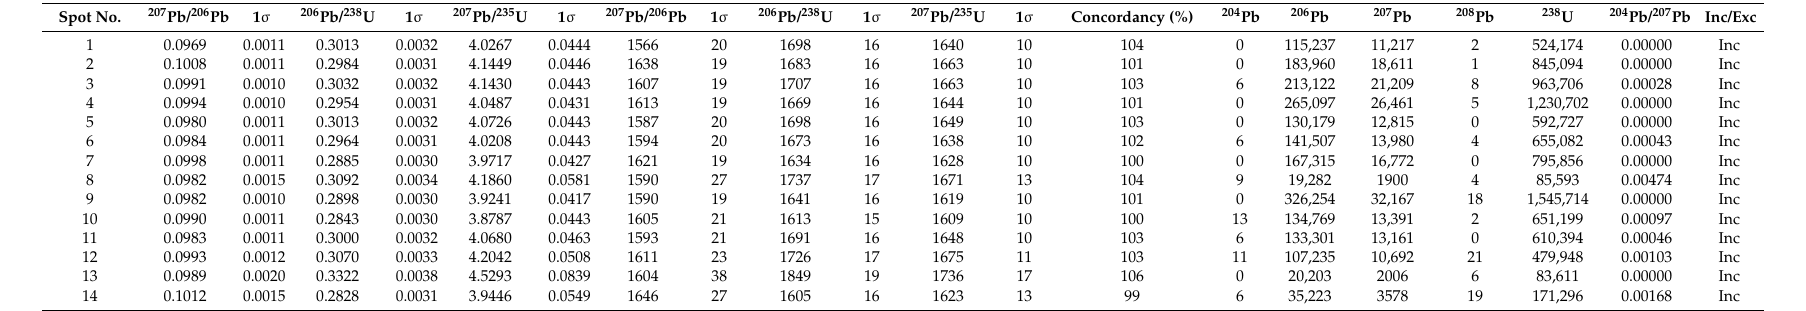
Table 3. Geochronological data for zoned hematite (sample PH-93) using mixed-solution method. Spot